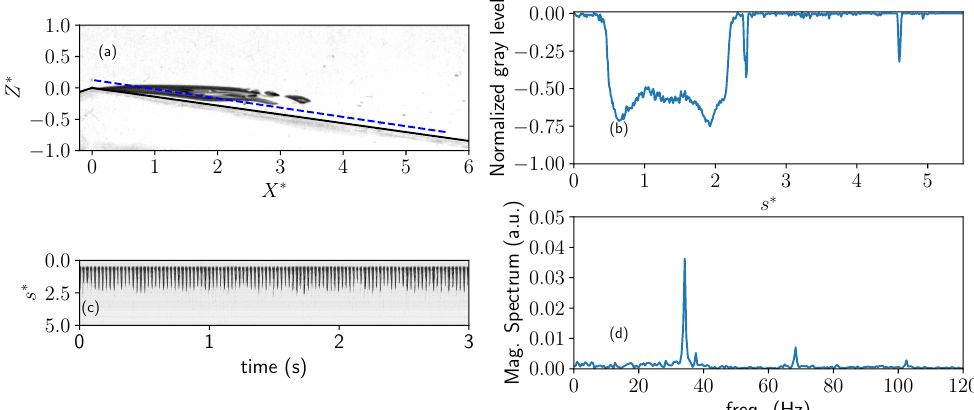
Figure 3. Illustration of image processing for the characterization of the temporal features of the attached cavities. ( a ): Instantaneous normalized side view I (cid:48) σ 2 = 1.17 0.03. ( b ): Gray level along the dashed blue line displayed in (a); s ∗ is the dimensionless ± curvilinear abscissa along the line. ( c ): Spatio-temporal diagram along the line; space is from top to bottom and time is from left to right. ( d ): Corresponding temporal magnitude